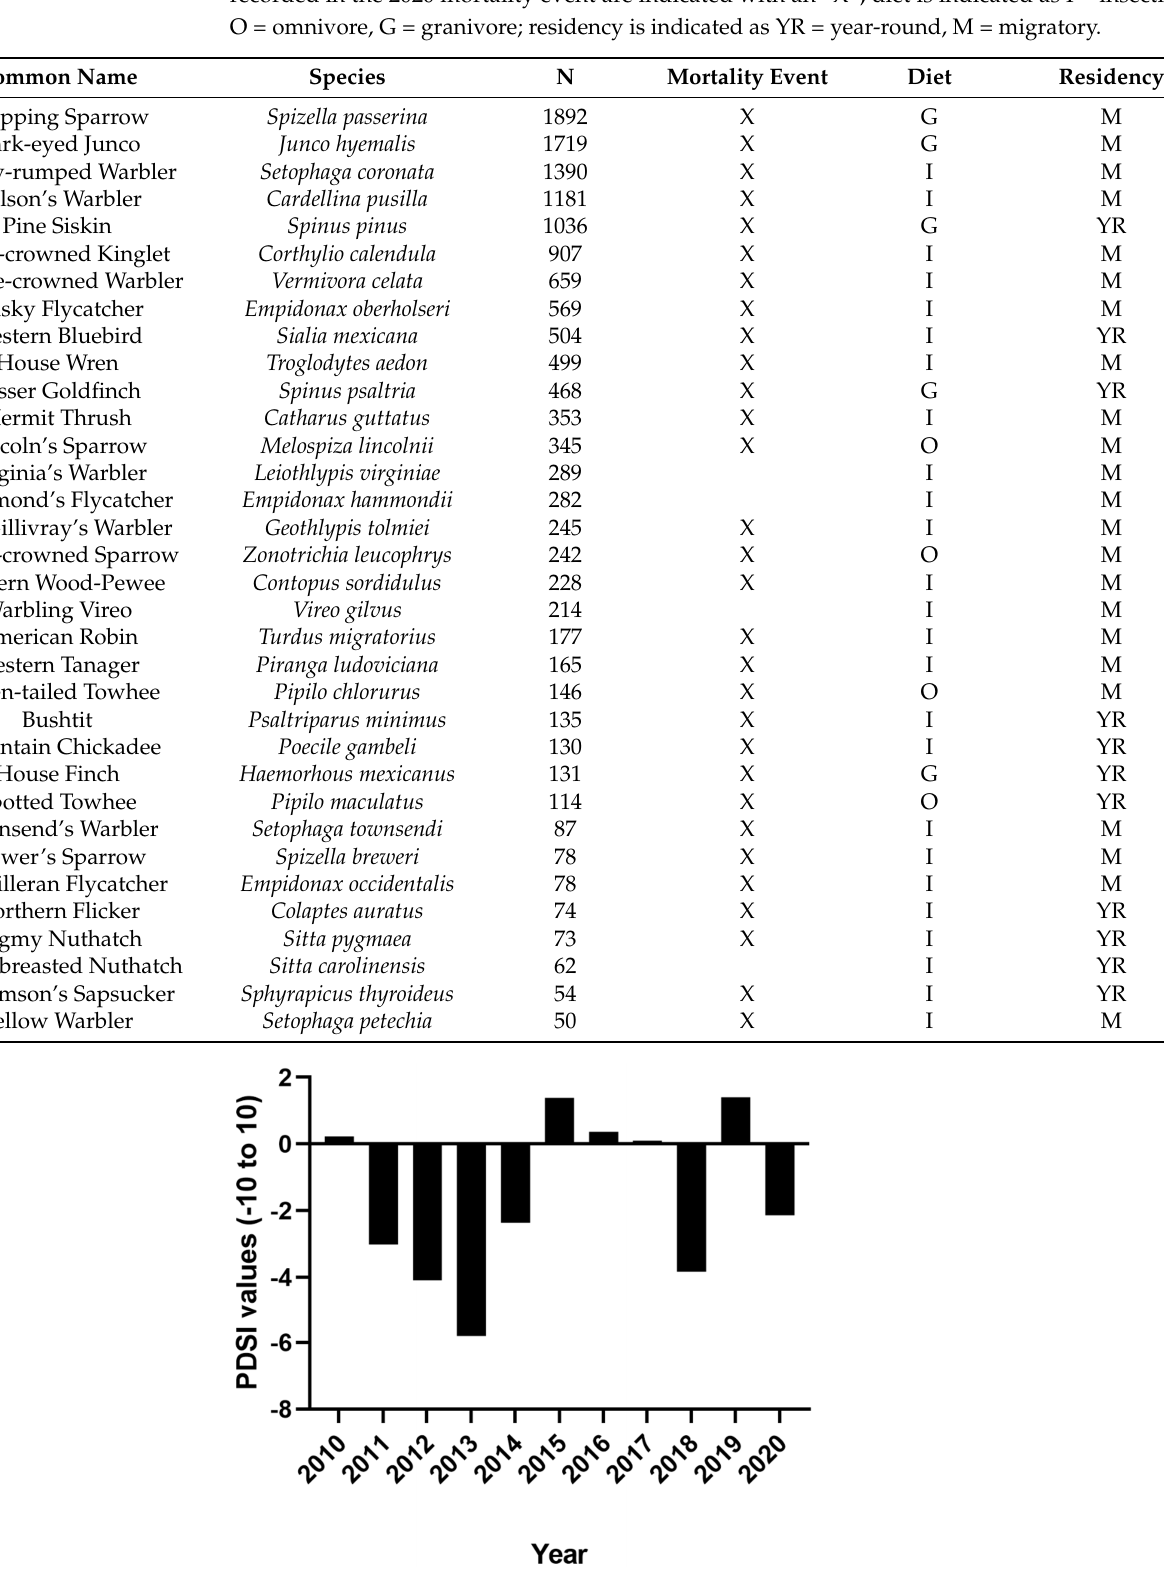
Table 1. List of species with ≥ 50 birds captured at fall banding sites from 2010 to 2020. Species recorded in the 2020 mortality event are indicated with an “X”; diet is indicated as I = insectivore,